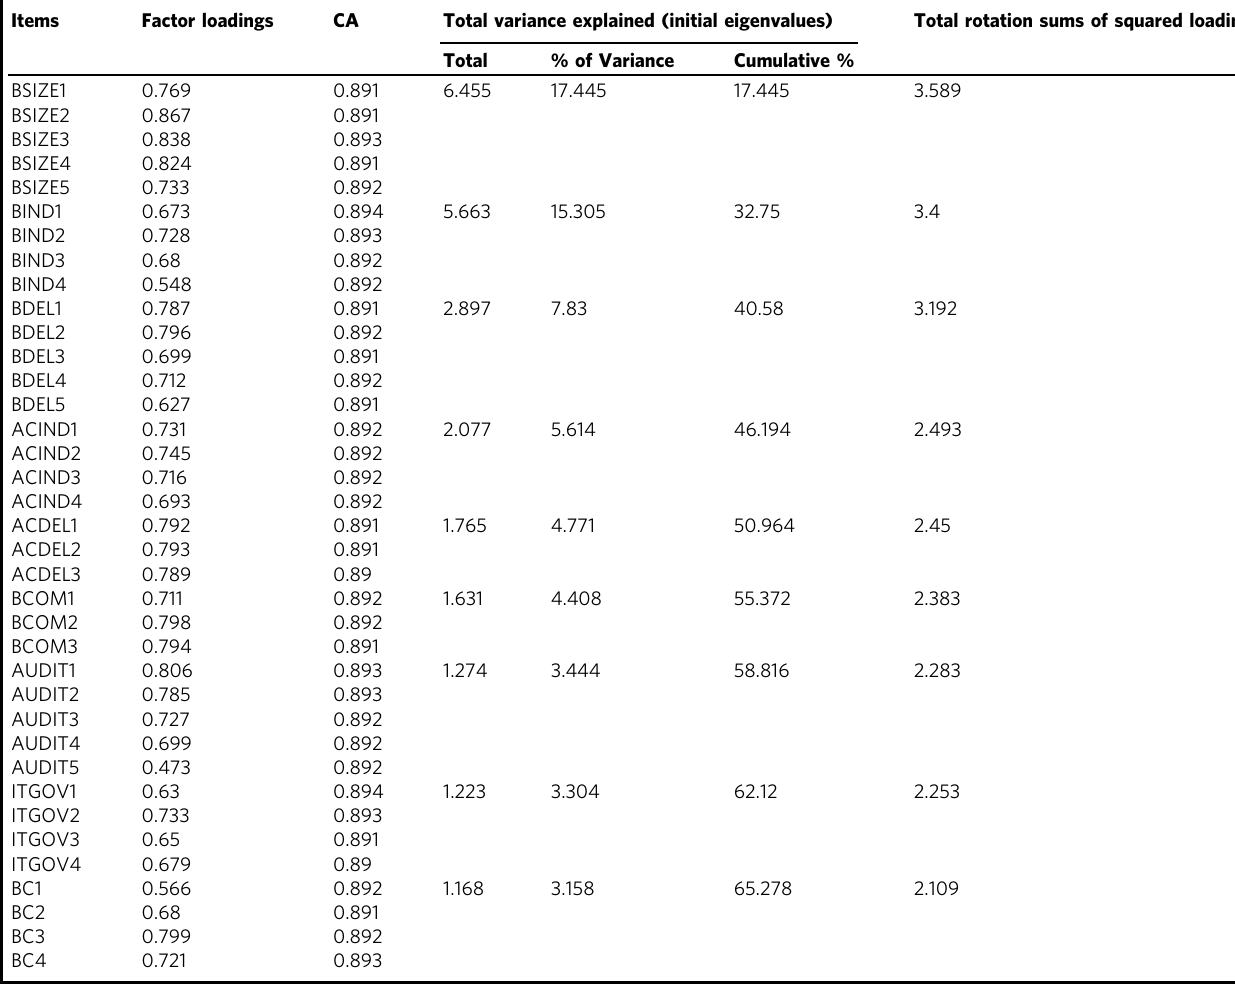
Table 4 Exploratory factor